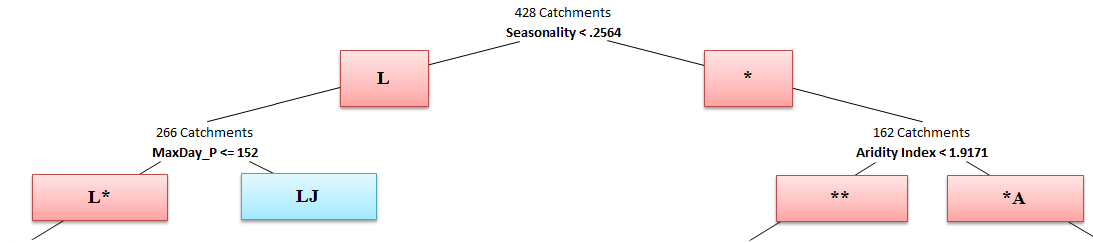
Fig. 6. The top two layers of the classification tree (terminal node shown in